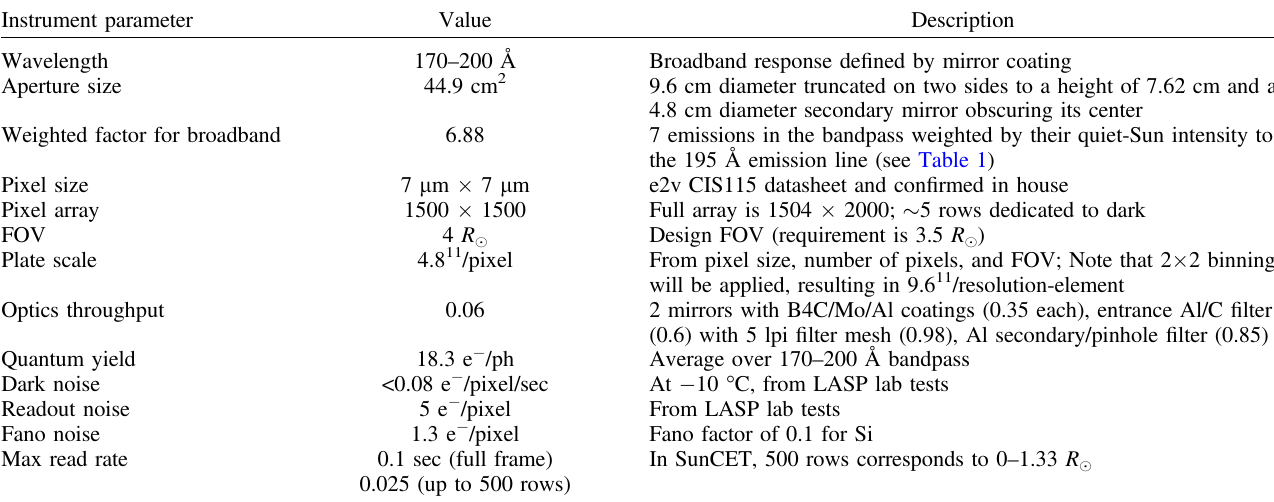
Table 3. SunCET instrument parameters needed to calculate SNR. Instrument parameter